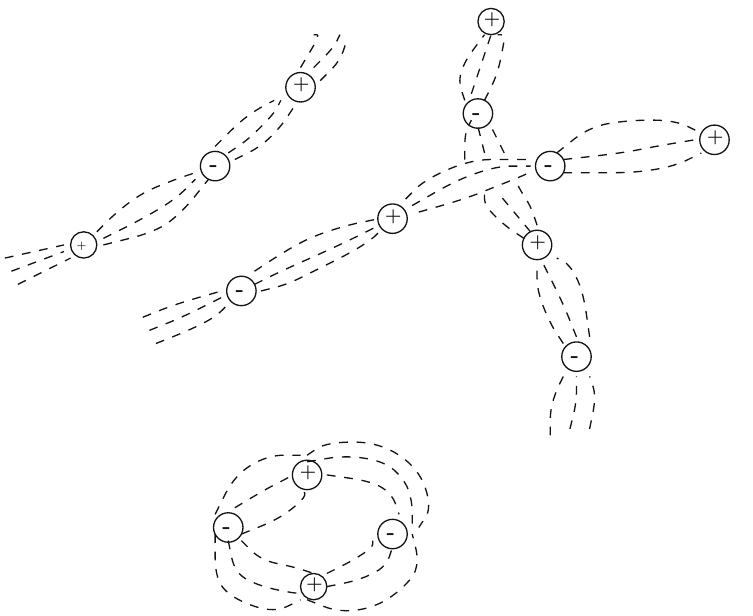
Figure 7. The formation of a center vortex through a collimation of the monopole/antimonopole flux. Fig. 9.6 Hypothetical collimation of monopole/antimonopole flux into center vortex tubes on the The figure is taken from Ref. abelian-projected lattice